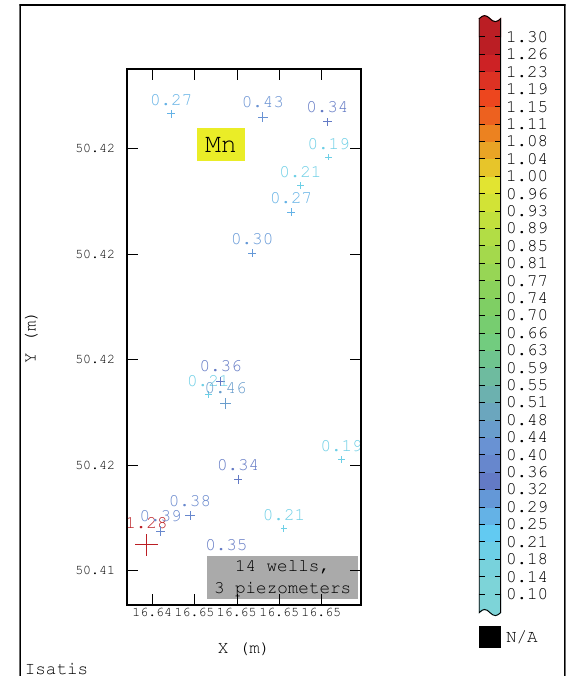
Fig. 2b. Base map of manganese Mn ++ content [g Mn ++ /m 3 ] in underground water for water intake area of Kłodzko (SW part of Poland); data coming from 14 wells + 3